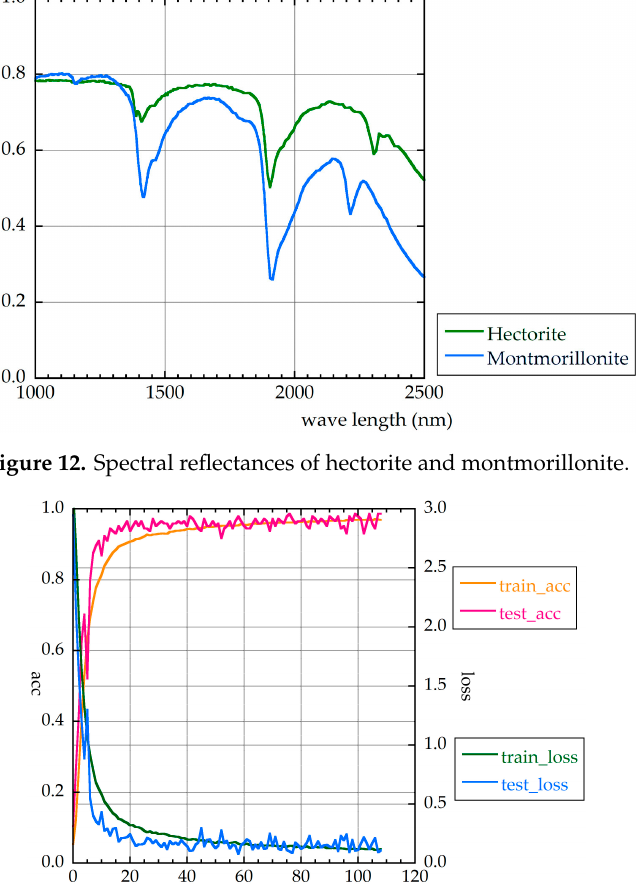
Figure 13. Accuracies and loss function values of MLP_M_HQ. Figure 14. Accuracies and loss function values of MLP_L_HQ. Figure 14. Accuracies and loss function values of MLP_L_HQ.